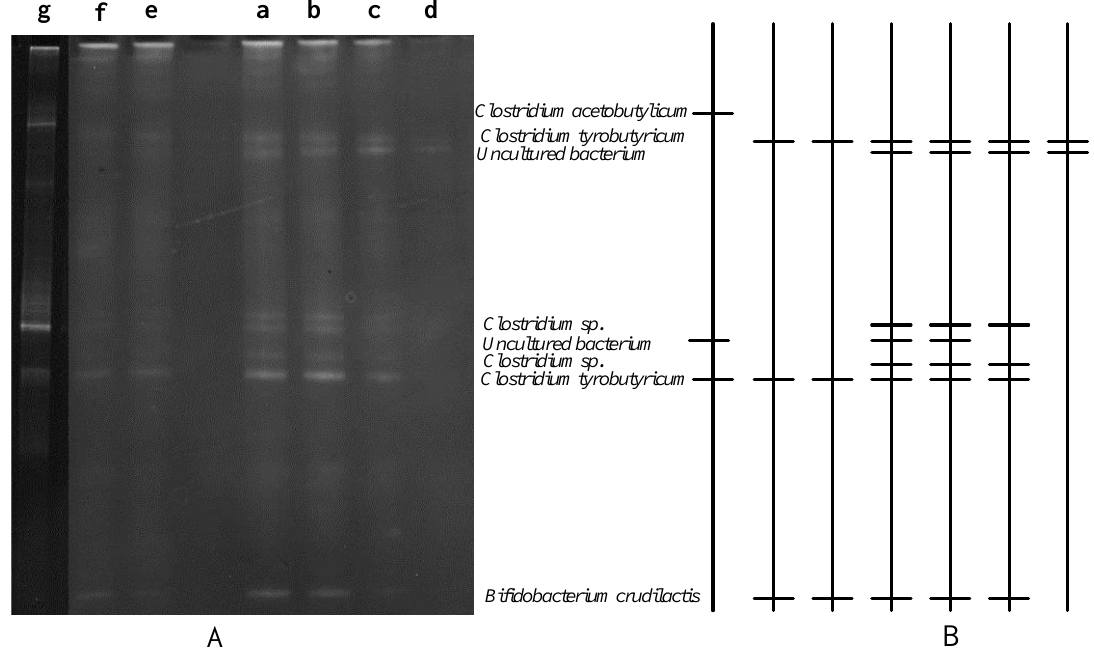
Figure 4. Microbial community diversity in packed-filter hydrogen production bioreactor under different operating conditions. ( A ) DGGE banding of PCR-amplified 16S rRNA gene from microbial DNA isolated, ( B ) patterns diagram, where a – d represent the feeding substrate concentration of 20, 10, 5, and 3.5 total sugar g/L when the position of the bioreactor was at h/H 2/4, whereas e – g represent the packed-filter position in the bioreactor (h/H) at 3/4, 1/4, and 4/4 when the feeding substrate concentration was 20 total sugar g/L.